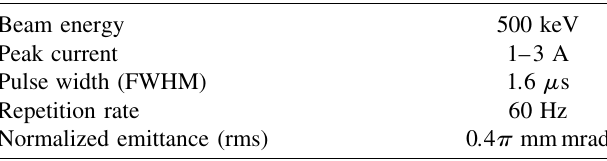
TABLE I. Beam design parameters at the gun